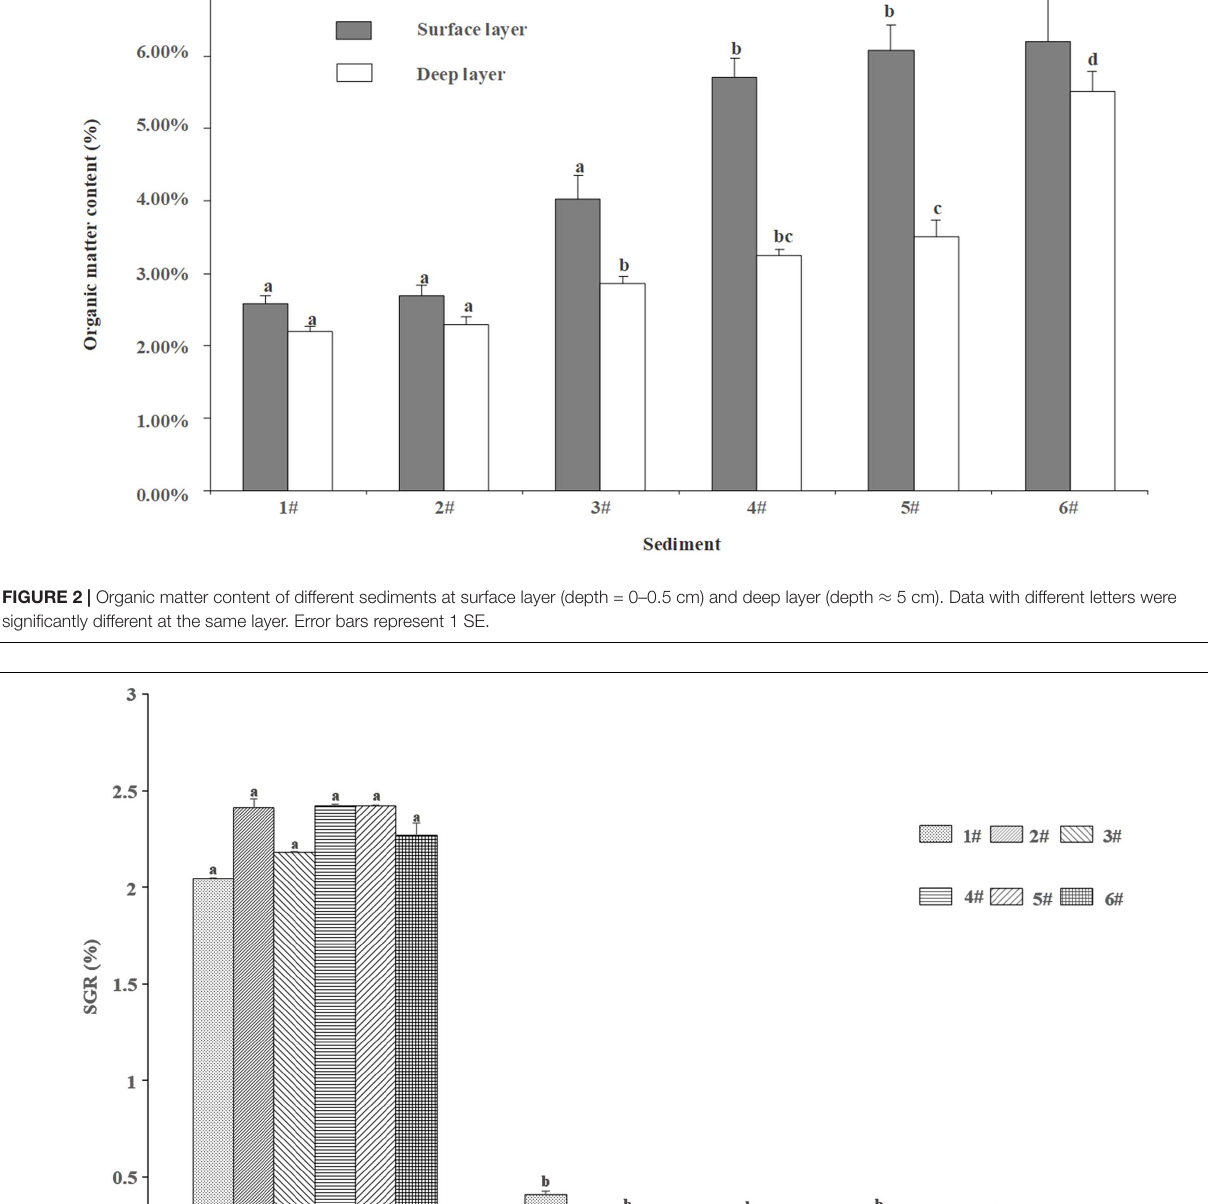
density of larvae (F = 0.302, p > 0.05). There was no significant difference in larval density among different sediments ( p > 0.05, Figure 4 ). The density of larvae increased with the